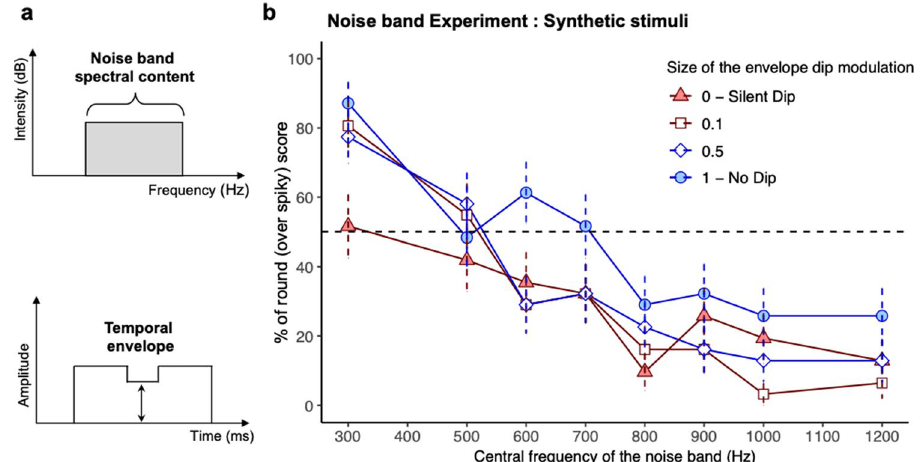
Figure 3. Stimuli manipulation and results from the Noise Band Experiment. ( a ) Top . Spectral content of the non-speech stimuli in the Noise Band Experiment made of bands of white noise, centered at values varying from 300 Hz to 1,200 Hz (Central frequency). Bottom . Amplitude modification of the stimuli to manipulate temporal continuity. Non-speech stimuli were 500 ms long and modulated by an envelope containing a dip from 225 to 275 ms, at an amplitude taking 4 possible values at 0, 0.1, 0.5 and 1 relative to the maximum value (Dip amplitude: 0 meaning a silent dip, and 1 meaning no dip at all). The amplitude was constant from 0 to 225 ms and from 275 to 500 ms. ( b ) Experimental results for the non-speech stimuli. The percentage of round (over spiky) score is averaged across participants as a function of the central frequency of the noise band and the size of the envelope modulation dip. Error bars are standard error from the